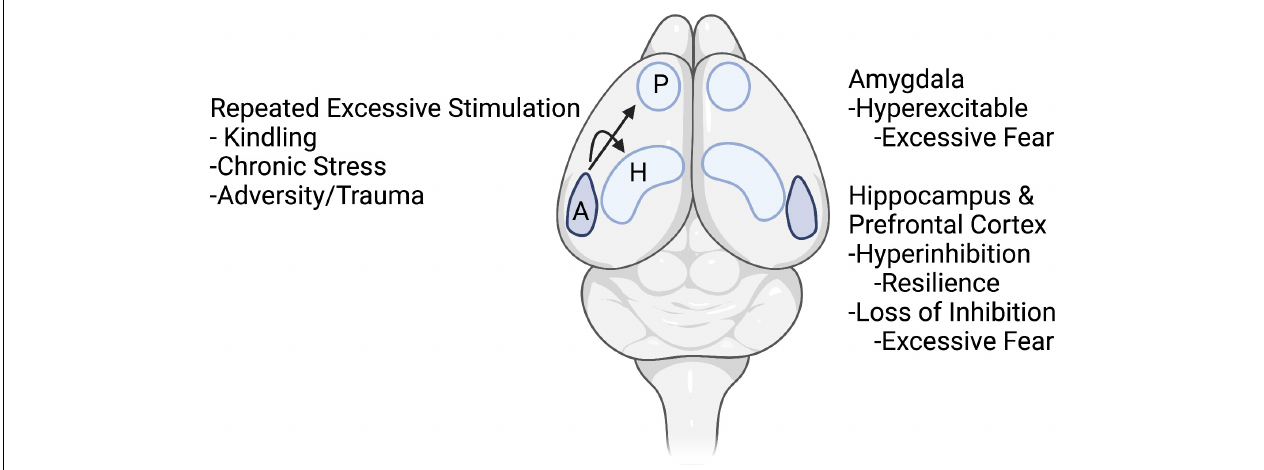
FIGURE 1 | Schematic drawing of topics of the article. It is hypothesized that repeated excessive stimulation of kindling, chronic stress, and trauma initiate changes in nodes of fear circuits. In amygdala, these events lead to hyperexcitability and excessive fear. In the hippocampus and prefrontal cortex, early stages of kindling and acute stress may lead to compensatory hyper-inhibition and resilience, whereas repeated kindling, stress, and trauma lead to loss of inhibition and excessive fear. Arrows from the amygdala (A) indicate excessive activity in the amygdala during kindling, stress, and trauma not only produces hyperexcitability in the amygdala but also causes changes in inhibitory and excitatory function in the hippocampus (H) and medial prefrontal cortex (P). Created with